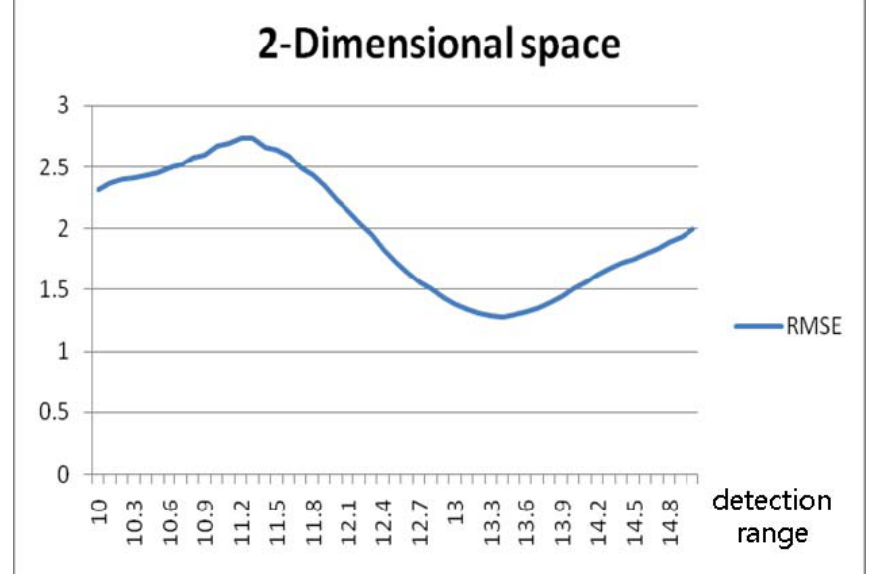
Figure 18. RMSE according to detection range in 2-dimensional